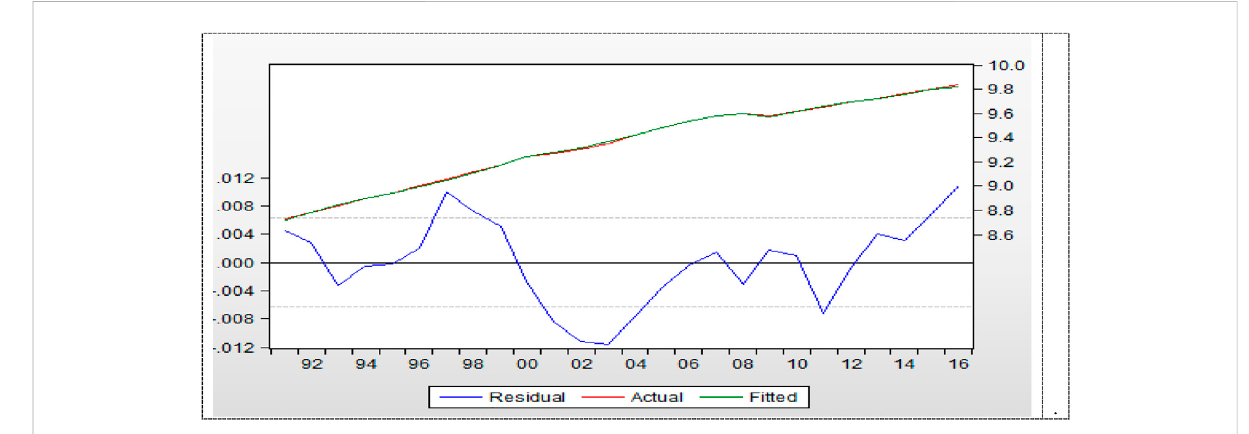
FIGURE 3 Check for heteroscedasticity.